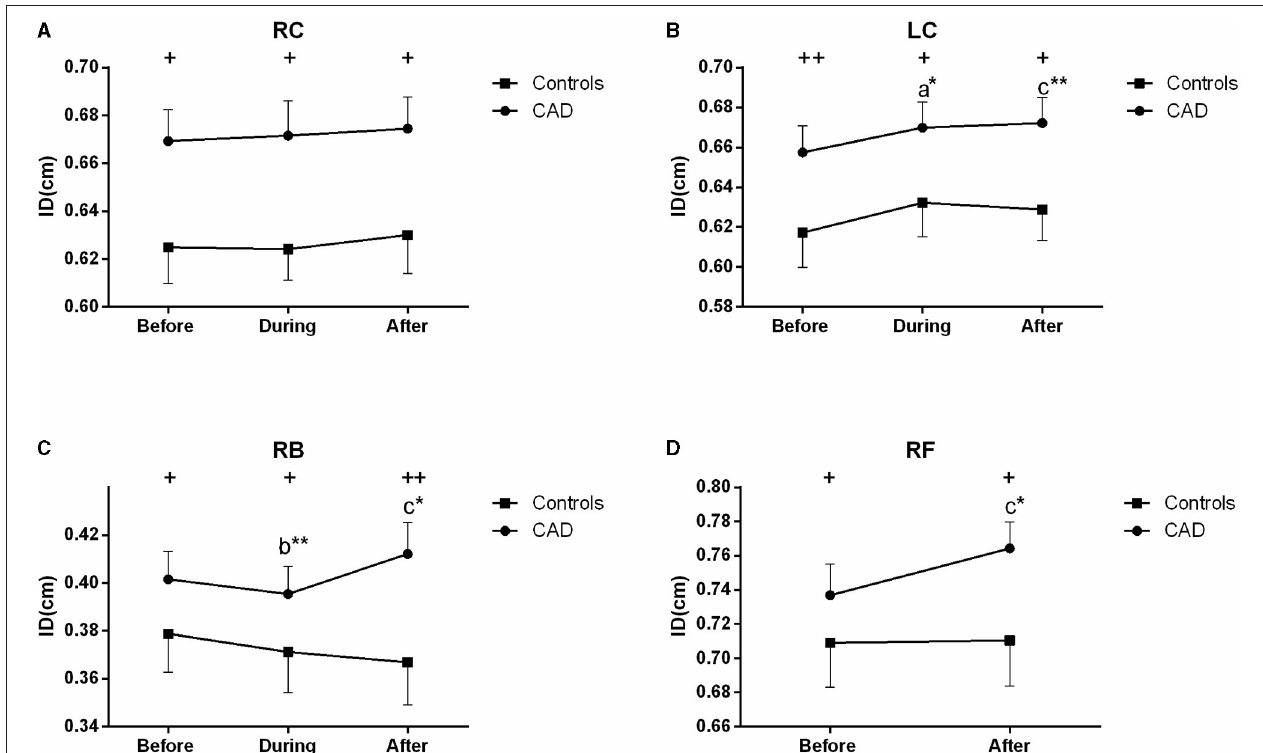
FIGURE 3 | Effect of EECP on the mean inner diameters (ID) of the left and right carotid artery (RC/LC) (A,B) , RB (C) , and right femoral (RF) artery (D) in the patients with coronary artery disease (CAD) and controls before, during, and after a 45 min-EECP. a indicates significant differences in measurements obtained during EECP vs. pre-EECP; b indicates differences between post-EECP vs. during-EECP, and c refers to comparisons between post-EECP vs. pre-EECP. “*” and “**” denote p < 0.5 and < 0.01 respectively. “ + ” and “ ++ ” denote p -values of the difference between groups < 0.5 and < 0.01,